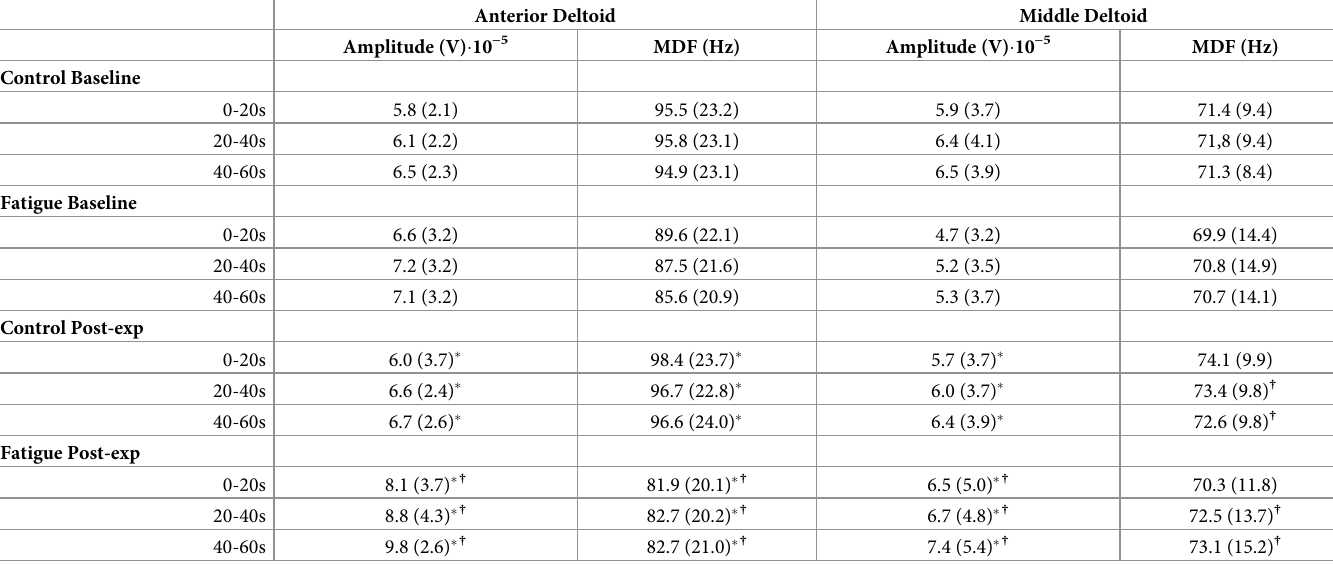
Table 2. EMG signals of the two groups during baseline and experimental